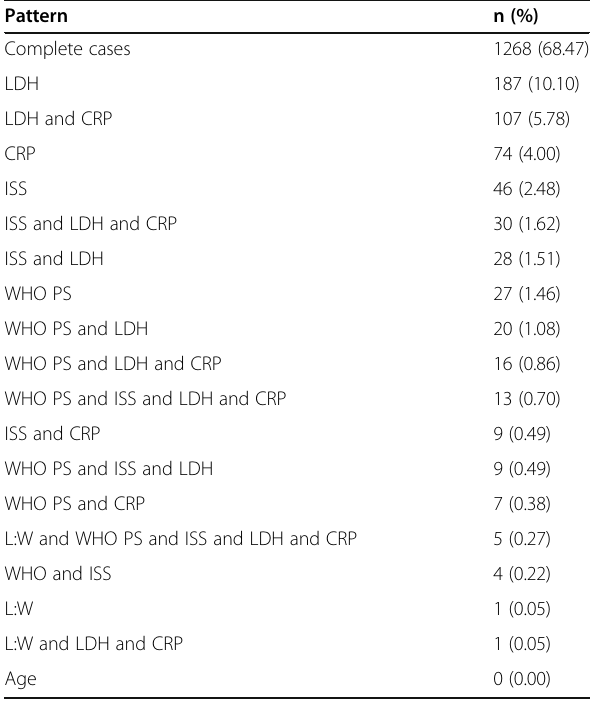
Table 2 Missing data pattern in the training dataset. The percentage of missing data for a single proposed prognostic factor within the training dataset can be calculated by summing all the patterns that include that